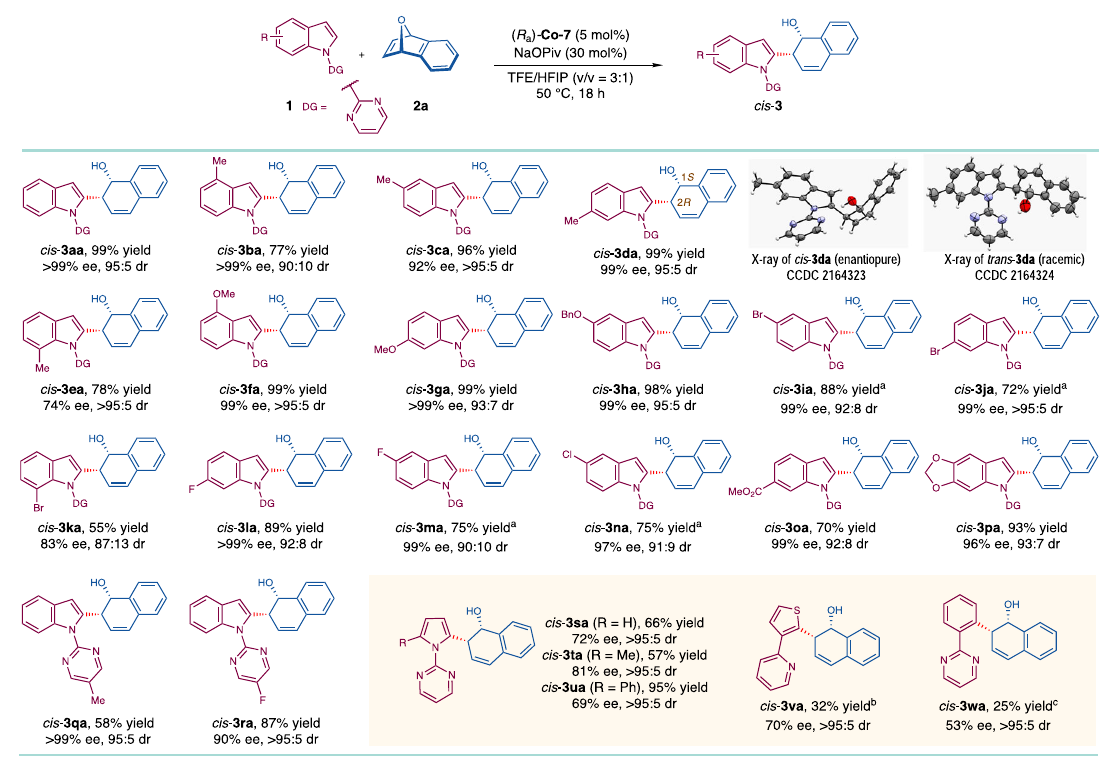
Fig. 2 | Substrate scope: Indoles and other arenes. Reaction conditions: 1 (0.10mmol) 2a (0.15mmol), ( R a )- Co-7 (5mol%), NaOPiv (30mol%) in TFE/HFIP (0.4mL,v/v=3:1)at50°Cfor18h.Note:(a)InTFE/HFIP/DCM(0.5mL,v/v/v=3:1:1) at 50°C for 18h. (b) ( R a )- Co-7 (10mol%), Zn(OAc) 2 (30mol%) instead of NaOPiv